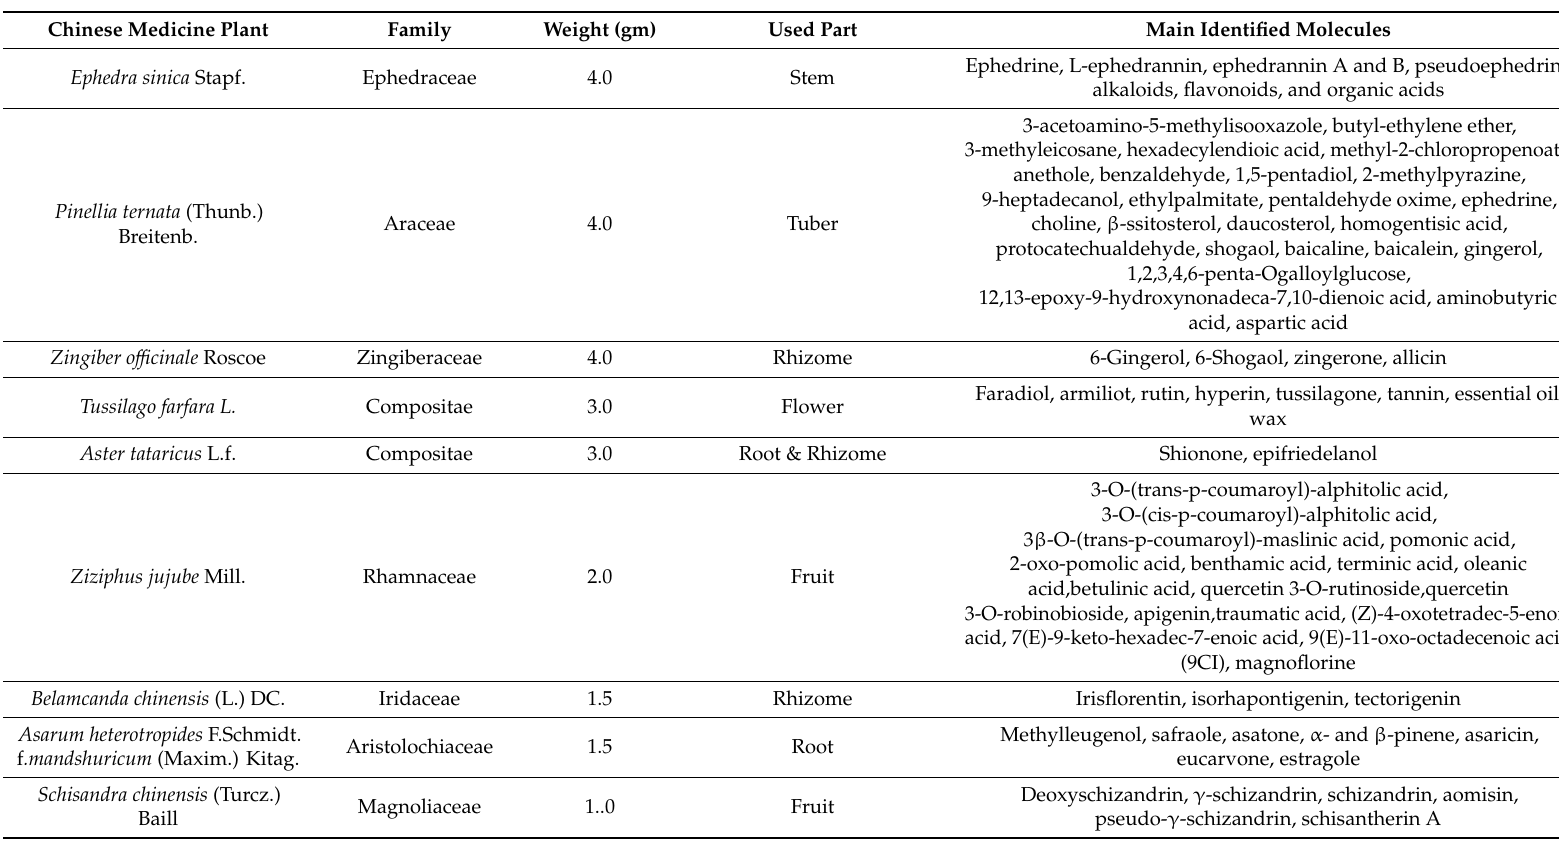
Table 5. Composition Ye-Gan-Ma-Huang-Tang (YGMHT; Yakammaoto in Japan; Shegan-Mahuang-Tang or Sheganmahuang Decoction in Chinese) [115]. Chinese Medicine Plant Family Weight (gm) Used Part Ephedra sinica Stapf.